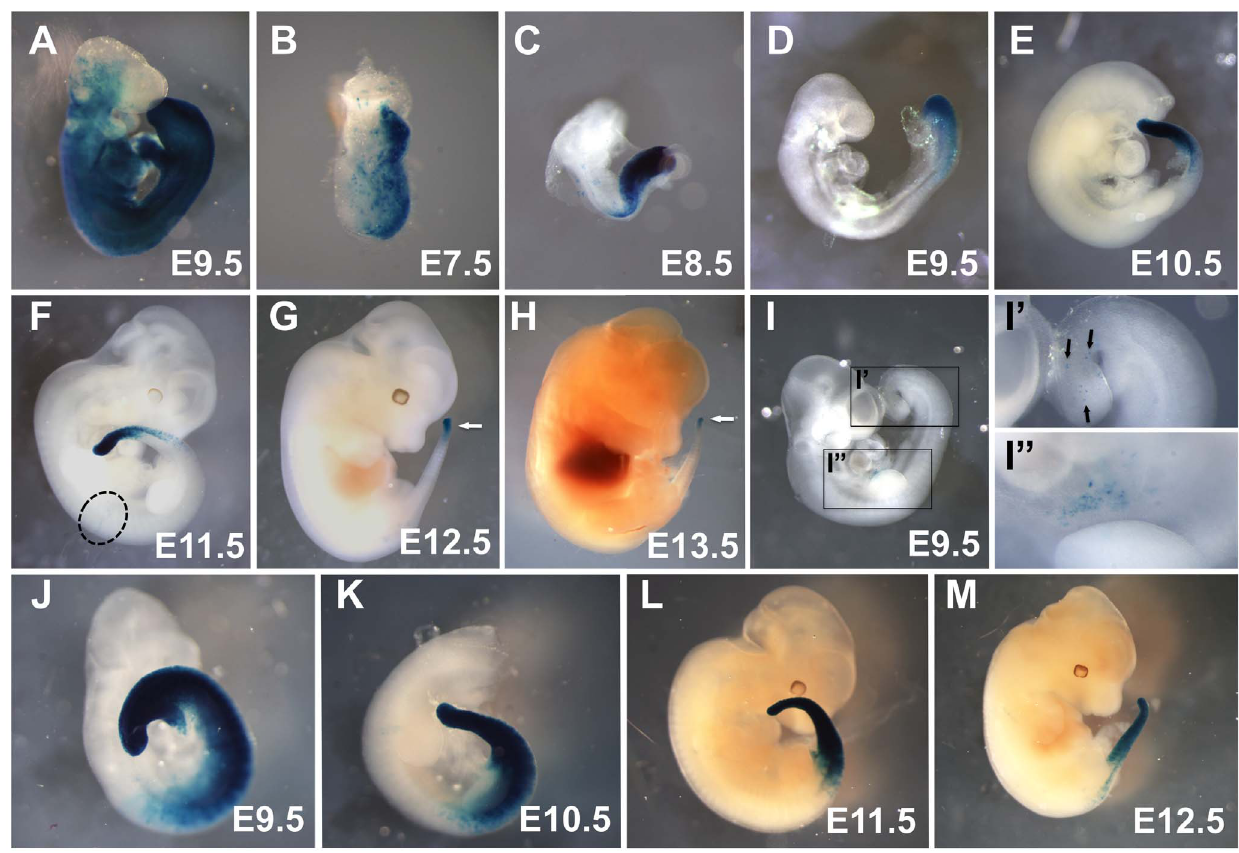
Figure 1. Tamoxifen adminstration induces TCreERT2-mediated recombination specifically in the primitive streak or tail bud. Embryos of the indicated age carrying either the TCre ( A ) or TCreERT2 transgenes ( B–M ) were assayed for activation of the R26R Cre-reporter by staining for ßGal activity (blue color). TCre; R26R control embryos ( A ) display widespread recombination at E9.5 compared to TCreERT2; R26R embryos, which, 24 hours after induction, have activated R26R only in tissues recently emerged from the primitive streak at E7.5 and E8.5 ( B, C ) or tailbud at E 9.5–13.5 ( D–H ) (white arrows in G and H ). An uninduced E9.5 TCreERT2; R26R embryo displays almost no blue cells ( I ) except for two small clusters ( I’ and I’’, which are enlargements of the boxed regions in I; arrows point to individual blue cells. A similar region is circled in F ). 48 hours after induction, TCreERT2; R26R embryos from E9.5–E12.5 display a recombined region that extends more rostrally ( J–M ) than in the case of a 24-hour induction